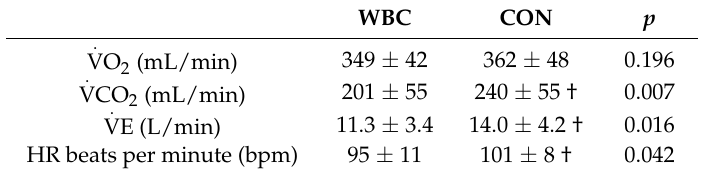
Table 2. Respiratory variables during post-exercise period in the WBC and CON trials.